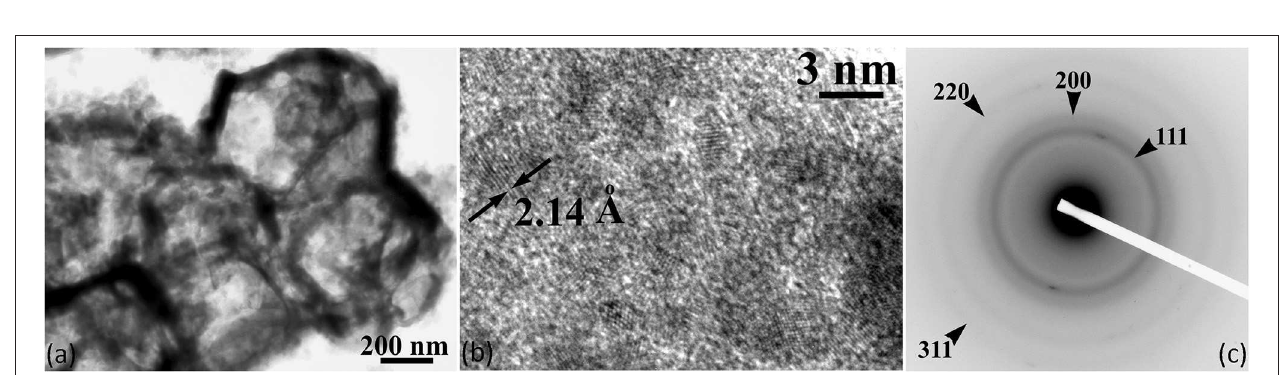
FIGURE 2 | (a) TEM micrographs illustrating the core-shell morphology of the CeO 2 @P(BA-b-AA) microcapsules, (b) HRTEM images showing the atomic structure of the core nanocrystals; the 3.12 Å interplanar spacing of the {111} crystal planes of CeO 2 is clearly resolved, (c) corresponding SAED from the core region. The diffuse ring pattern is characteristic of a nanocrystalline material. The {111}, {220}, and {311} reflections of CeO 2 are clearly determined.